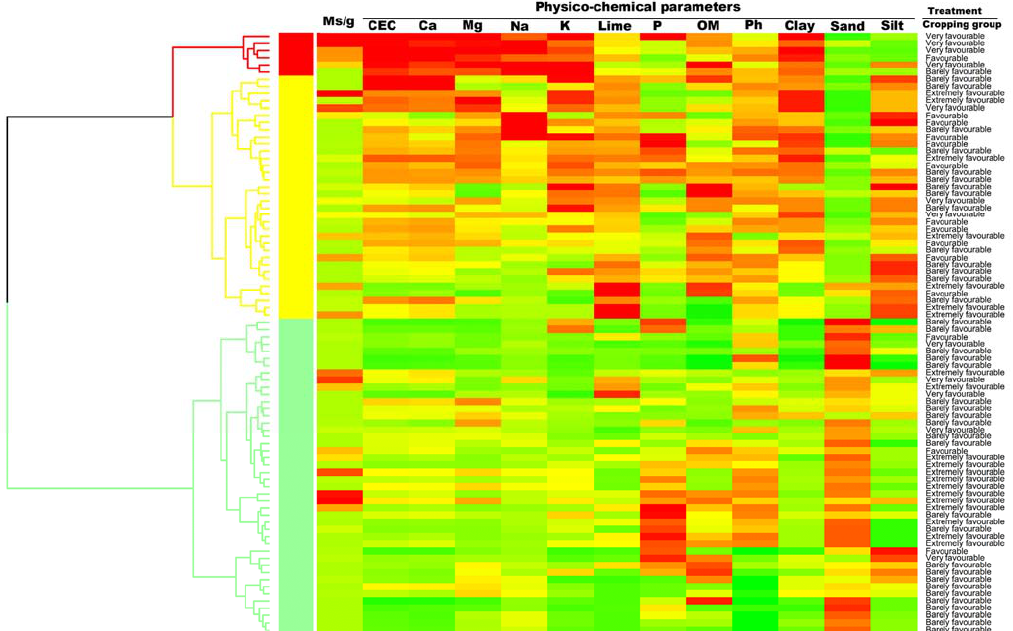
Figure 4. Dendrogram derived from cluster analysis of 4 experimental treatment combinations in a study where the effect of previous cropping history was assessed on densities of Verticillium dahliae in olive-growing areas of the Iberian Peninsula and heat map representation of the ID and soil physicochemical parameters. The 12 parameters selected for the heat map representation were CEC (meq 100g − 1 ), Ca (meq 100g − 1 ), Mg (meq 100g − 1 ), Na (meq 100g − 1 ), K (meq 100g − 1 ), P (meq 100g − 1 ), lime (%), OM (%), pH, and percentage of clay, sand, and silt. Agglomerative cluster analyses were performed based on the Spearman correlation matrix calculated from values of the different parameters using the Ward method. Clusters of experimental treatment combinations, depicted in different colors, were estimated on the basis of the average silhouette width according to the Mantel statistic. In the heat map, in each column, cells represent the value of each parameter for each experimental treatment combination of four previous cropping history groups (VWO with a barely favourable previous cropping history, with <2 host crops of V. dahliae in the previous five years; VWO with a favourable previous cropping history, with 3 host crops of the fungus; VWO with a very favourable previous cropping history which indicated that in only one of the previous five years the plot was free of V. dahliae hosts; and VWO with an extremely favourable previous cropping history which indicated that during all the five previous years the species susceptible to V. dahliae were cropped in the plot) from 84